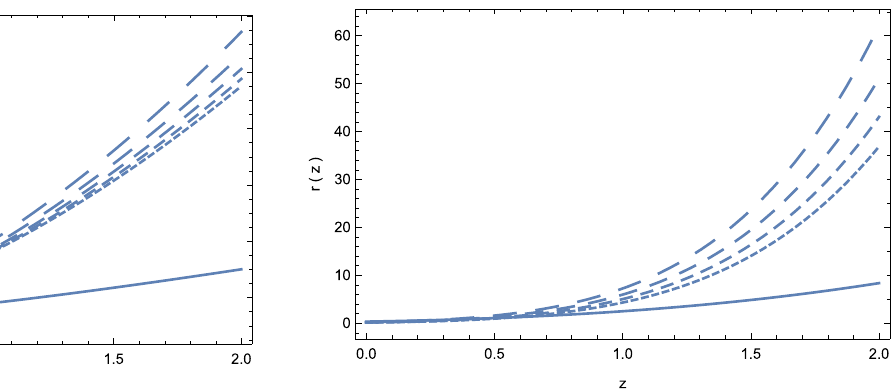
(cid:12) (cid:11) ˜ Q , ˜ T =